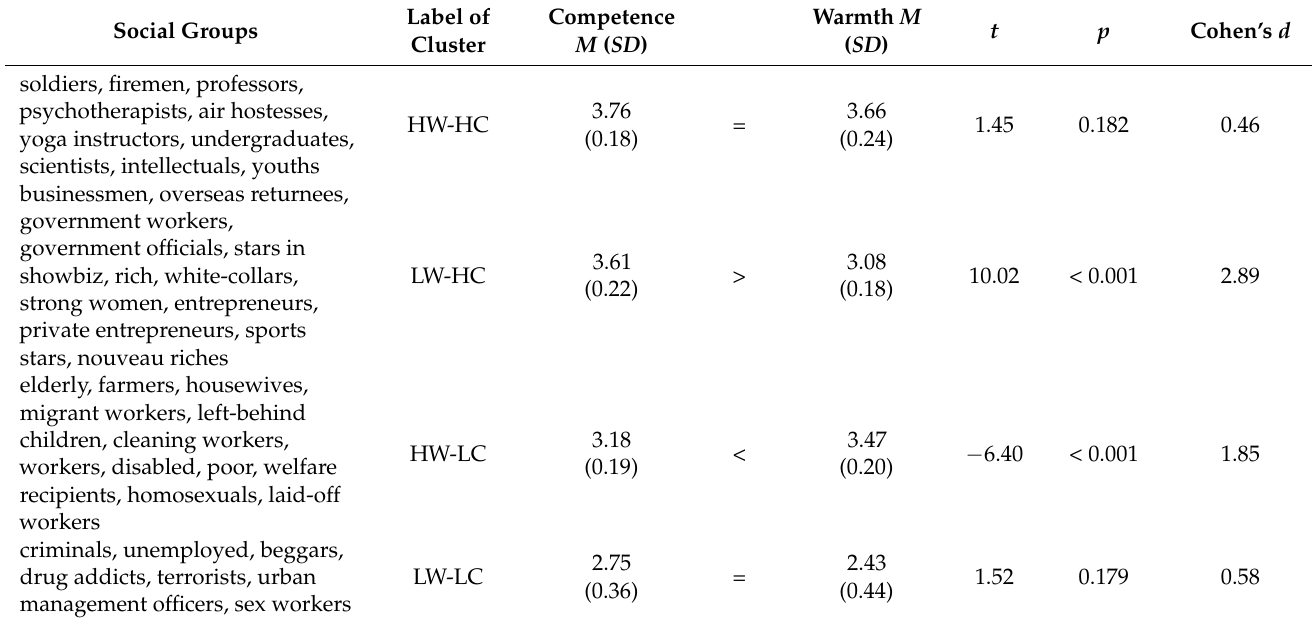
Table 5. The descriptive data and paired t-test results of warmth and competence for four social group clusters (based on 41 social